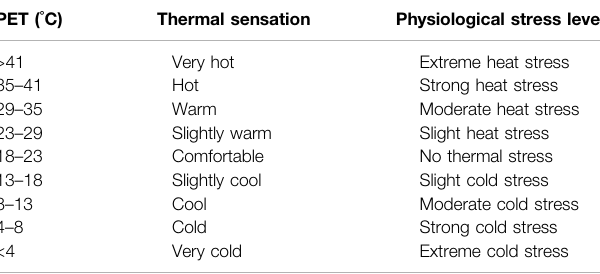
TABLE 2 | PET for different grades of thermal sensation. PET ( °